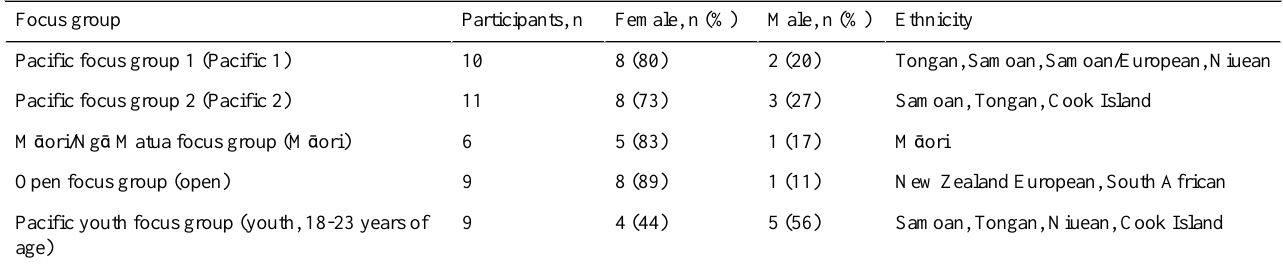
Table 1. Type of group, numbers, sex, and ethnicity of participant focus groups.